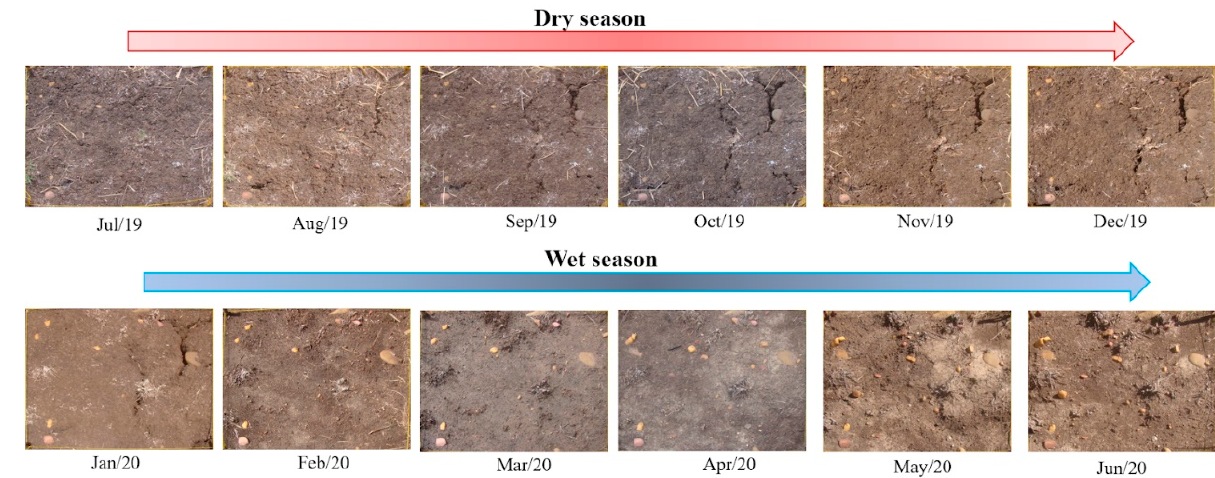
Figure 3. Monthly development of soil cracks in an experimental plot. The crack monitoring consisted of the in situ location of the cracks and the measure- ment of their respective depth. Cracks were identi fi ed with the aid of a 0.05 m × 0.05 m net placed over the 1 m 2 experimental plots, totaling a mesh of 400 points (Figure 4). The crack depth was measured using a 4 mm diameter rod and a ruler at the intersection of each crack and the 0.05 m × 0.05 m net (Figure 4).